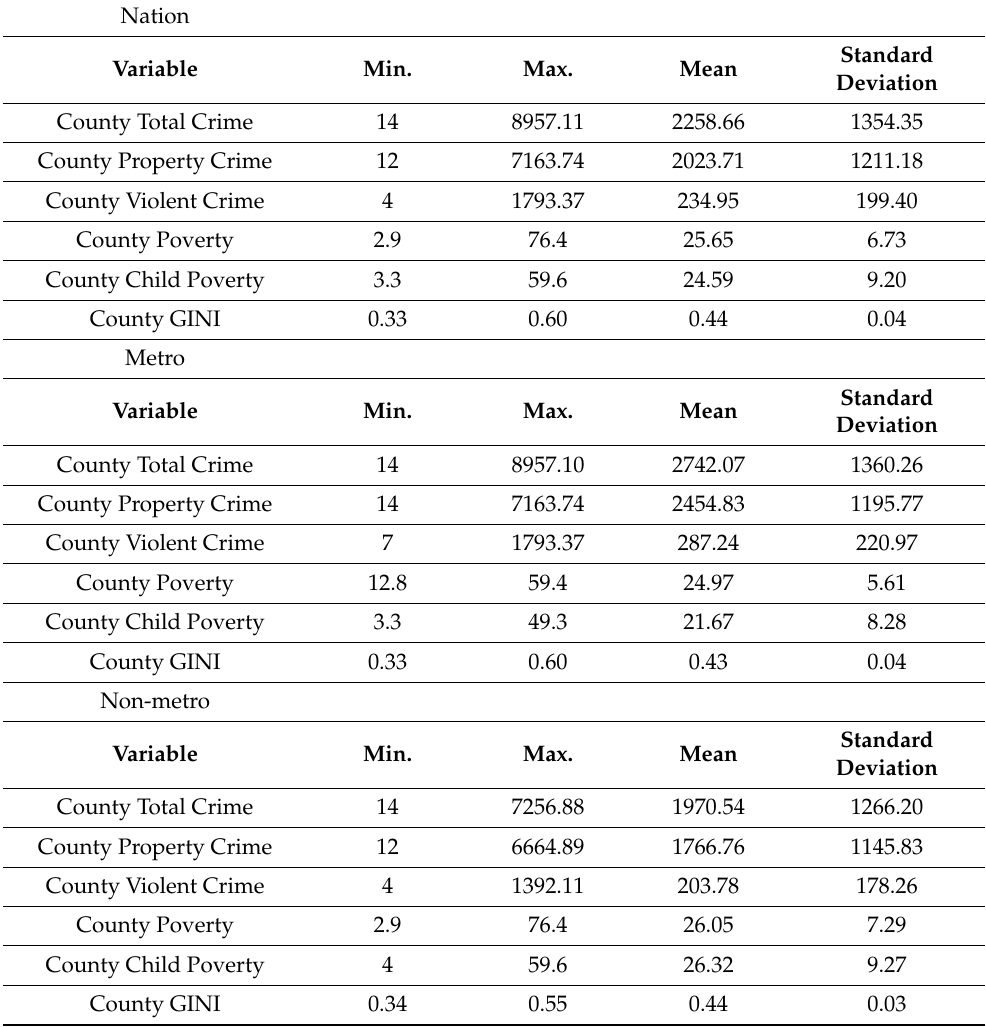
Table A9. Descriptive statistics for other social amenities.